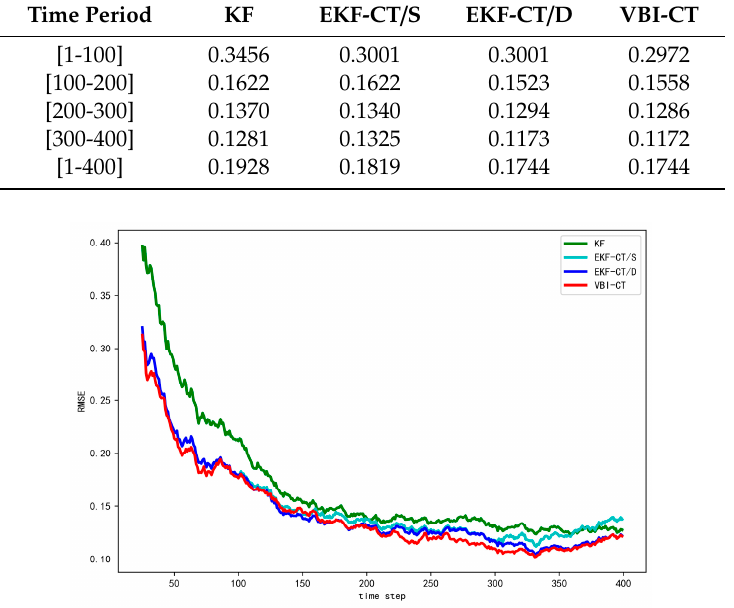
Figure 6. Variation curves of tracking errors obtained by di ff erent algorithms when σ 2 = 0.2 .